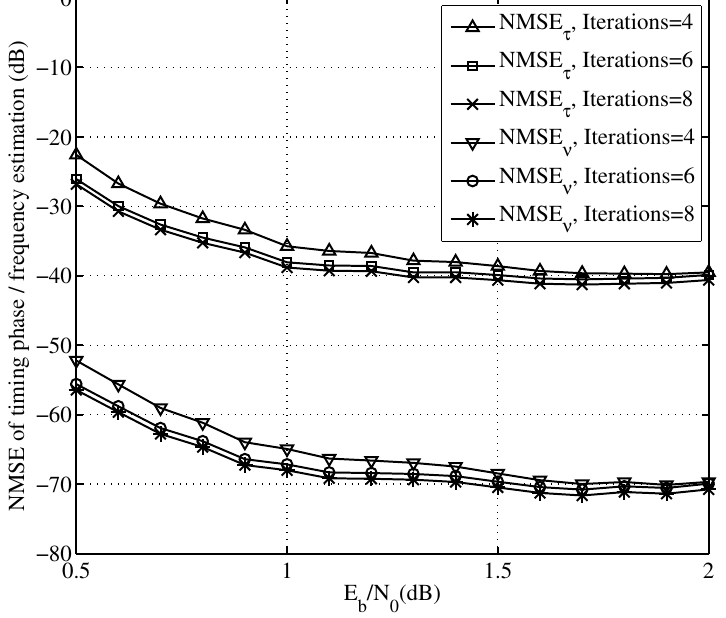
Figure 6. NMSE of the timing phase and frequency estimation with an average of 50 times for each E b / N 0